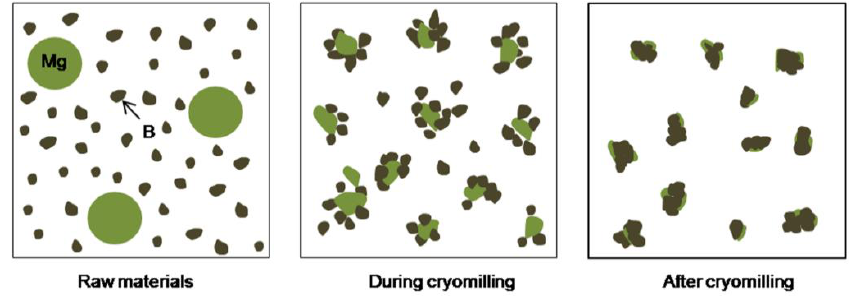
Figure 10. Illustration of the compound mechanism of Mg/B2